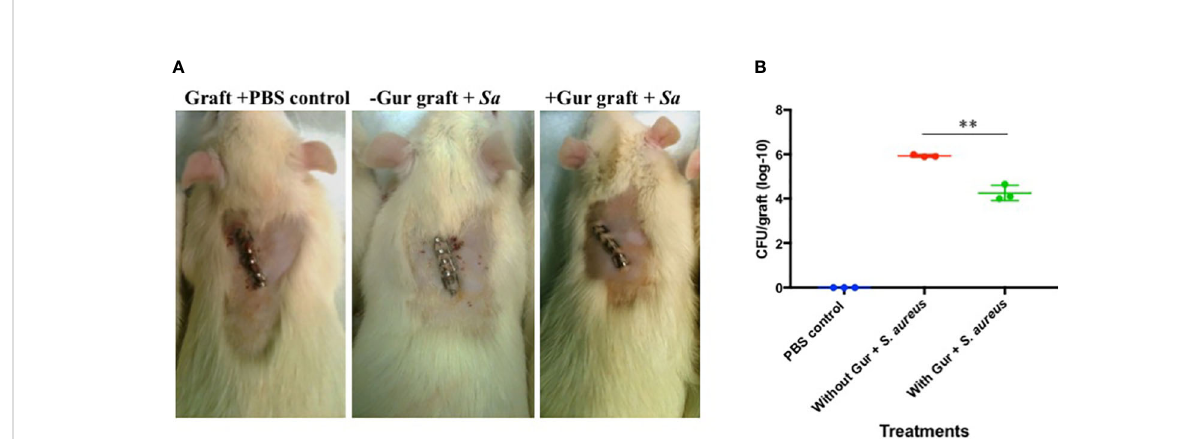
FIGURE 5 Rat-graft model of bio fi lm assay. (A) A representative animal for each group 7 days post-infection is shown. Small graft mesh (1 cm 2 ) soaked in PBS (control) or gurmarin solubilized in PBS (treated) was placed in a subcutaneous pocket on the median shoulder of an anesthetized rat and closed with skin clips. Immediately, PBS (negative control group) or Sa suspension in PBS (positive control group and treatment group) were instilled in the respective group of animals at the closures and monitored for 7 days. Note, the middle image has ‘ subcutaneous swelling ’ and ‘ subdermal discoloration ’ both consistent with necrocellulitis. (B) Seven days after implantation, grafts were retrieved from the pockets and determined for the Sa bio fi lm cells (CFU). ** p <